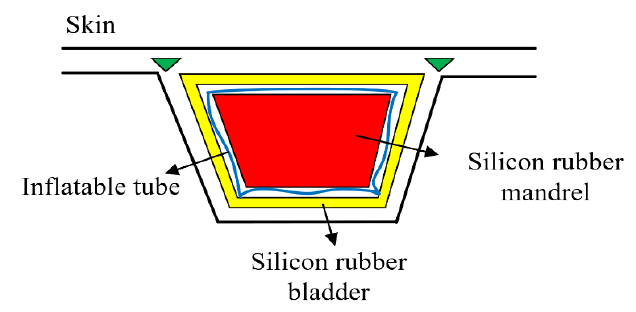
Figure 2. Composite autoclave molding process principle.